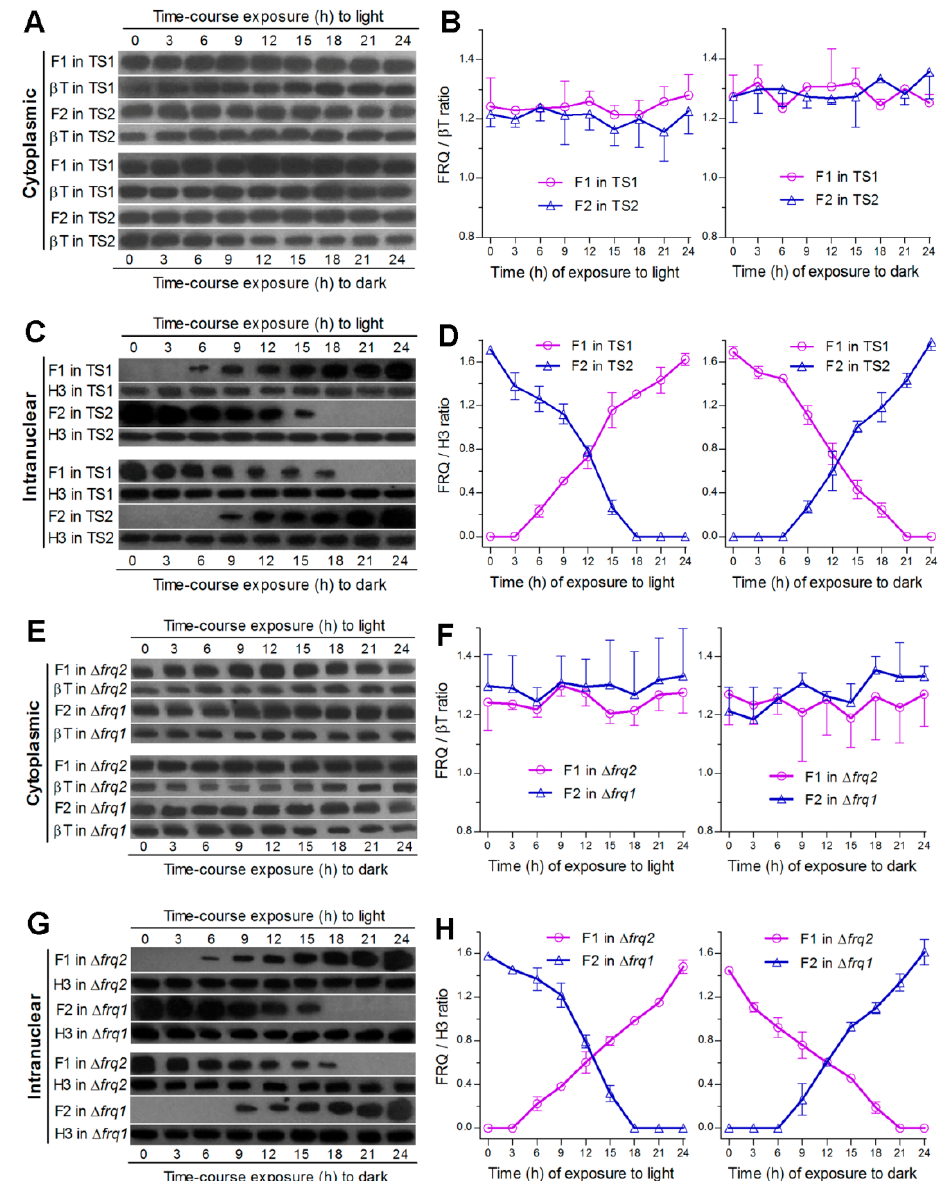
Figure 2. Intracellular expression dynamics of Frq1 and Frq2 in time-course responses to light and dark cues. ( A – D ) Time-course western blots and relative expression levels of Frq1::GFP (F1) and